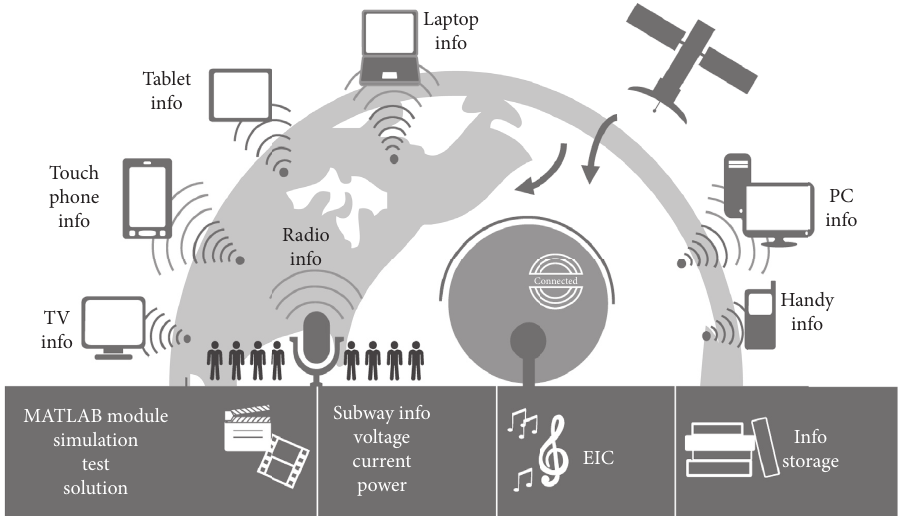
Figure 2: Common traction power supply system. The information is shown in the